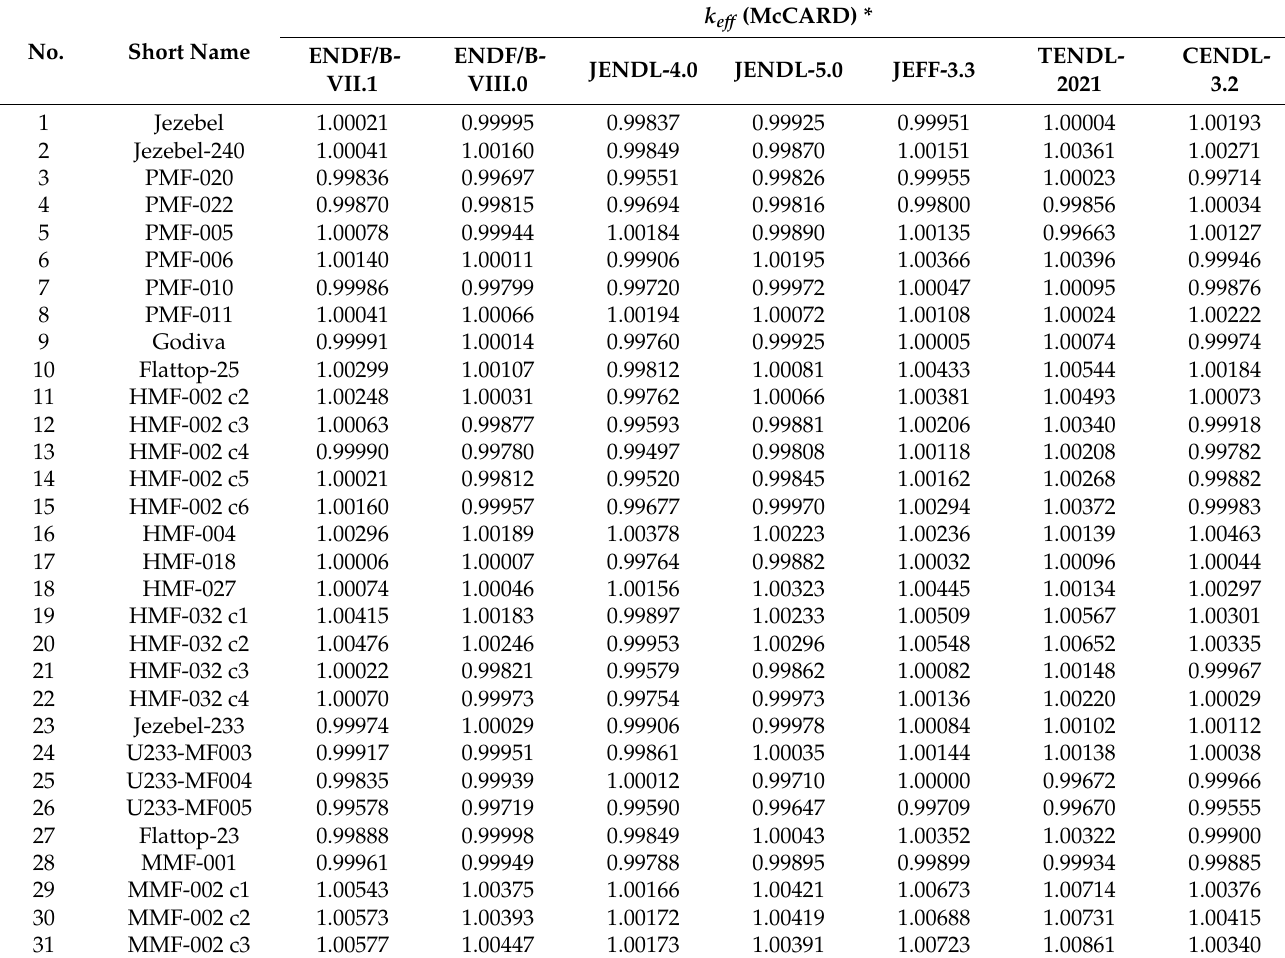
Table 3. k eff values for the fast benchmarks with the different evaluated nuclear data